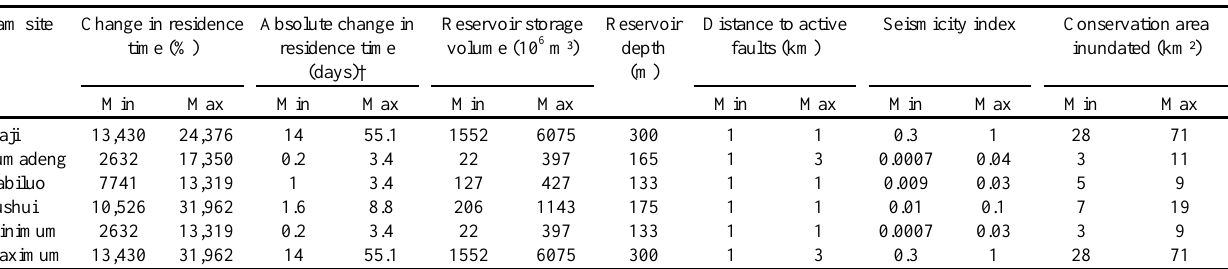
Table 5. Projected biophysical vulnerabilities to proposed hydropower development based on modeled reservoirs of the Nu River,